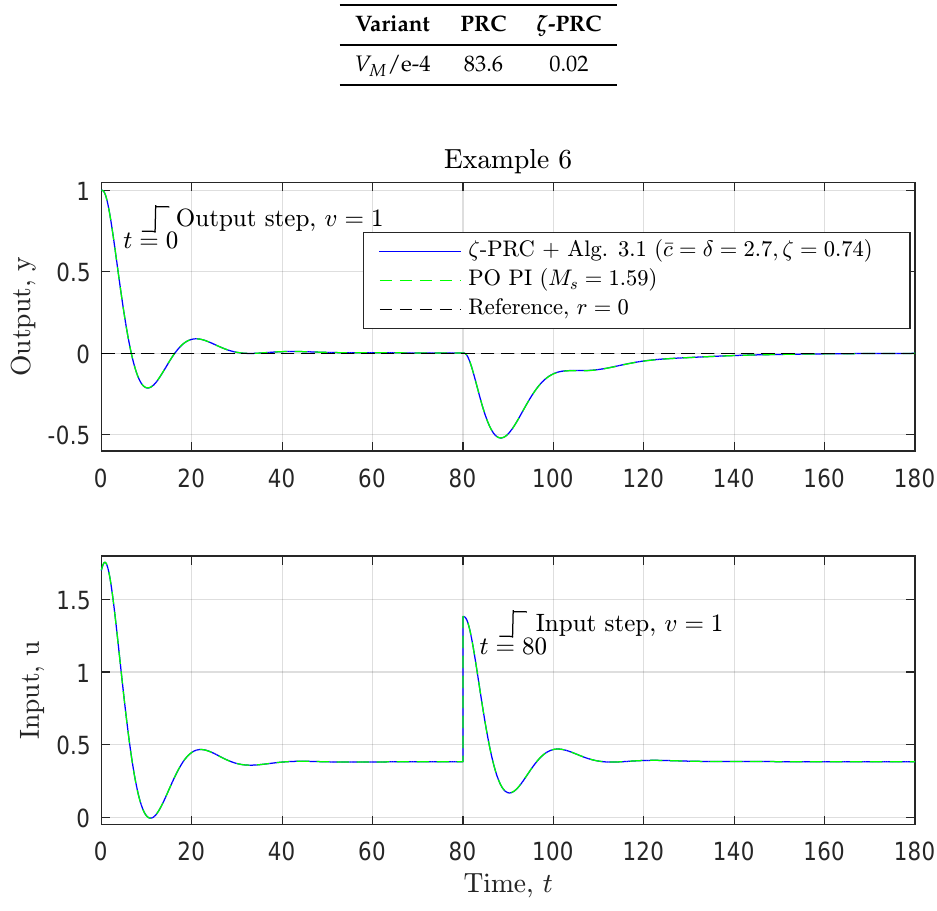
Figure 13. Example 6. PI control of the higher order underdamped process model (Equation (48)). The figure illustrates the time-domain responses, given a prescribed robustness M s = 1.59, for the following methods: the PO PI and the ζ -PRC + Algorithm 1 variant with MP parameter and MTDE settings ¯ c = δ = 2.7, and tuning parameter ζ = 0.74. An output disturbance unit step is presented at time t = 0 and an input disturbance unit step at time t =